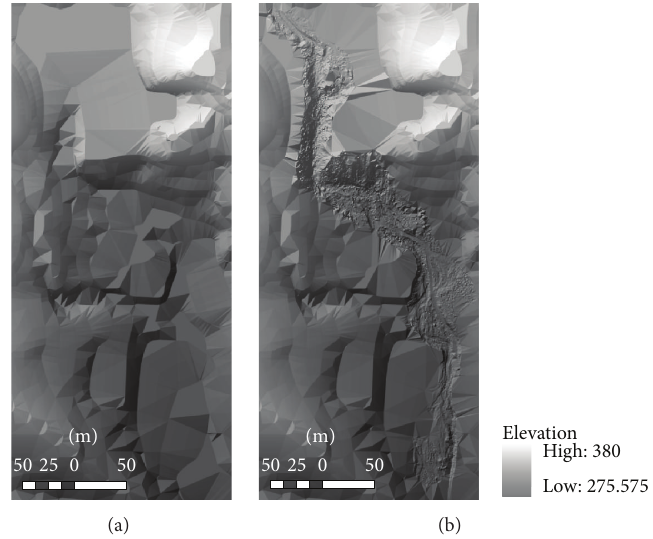
Figure 7: Topographic map before (a) and after (b) debris flow.